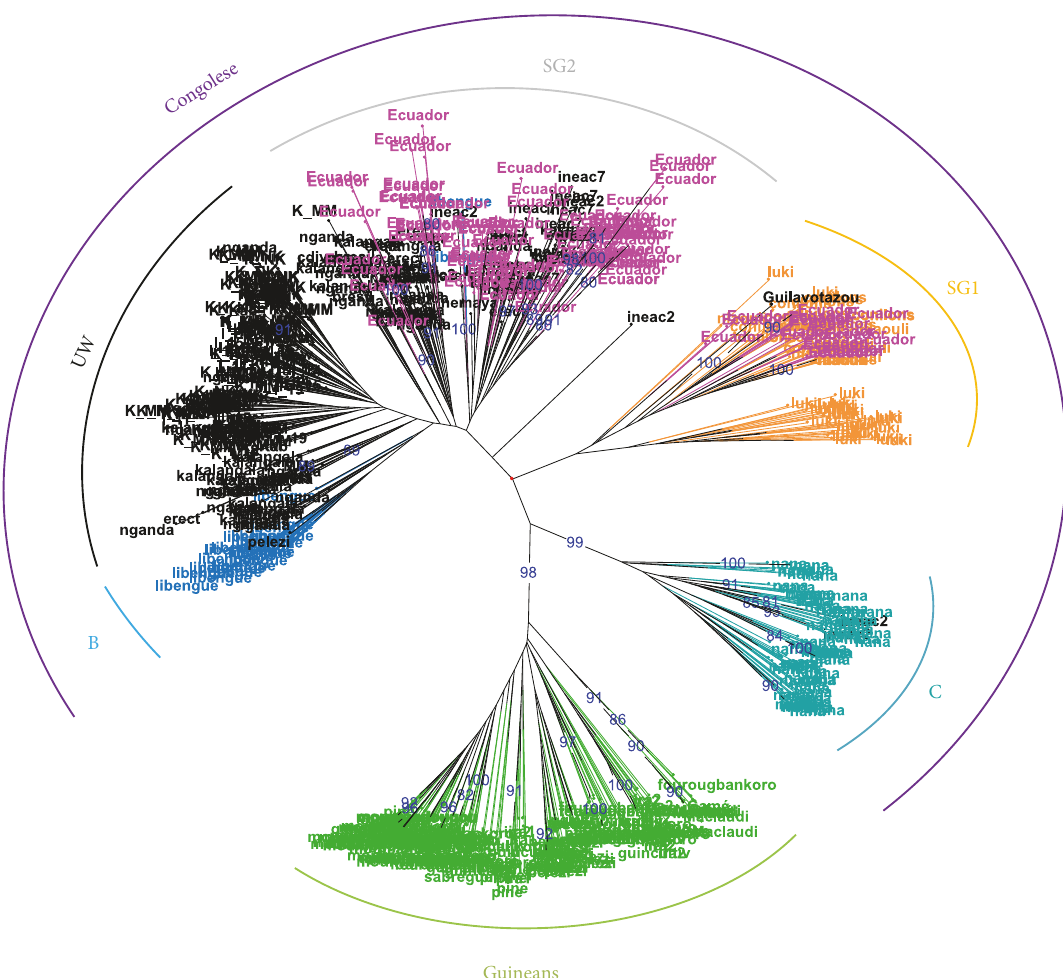
Figure 1: Genetic diversity of 137 Ecuadorian Coffea canephora accessions within the known diversity of the species (NJ-Tree from data produced in